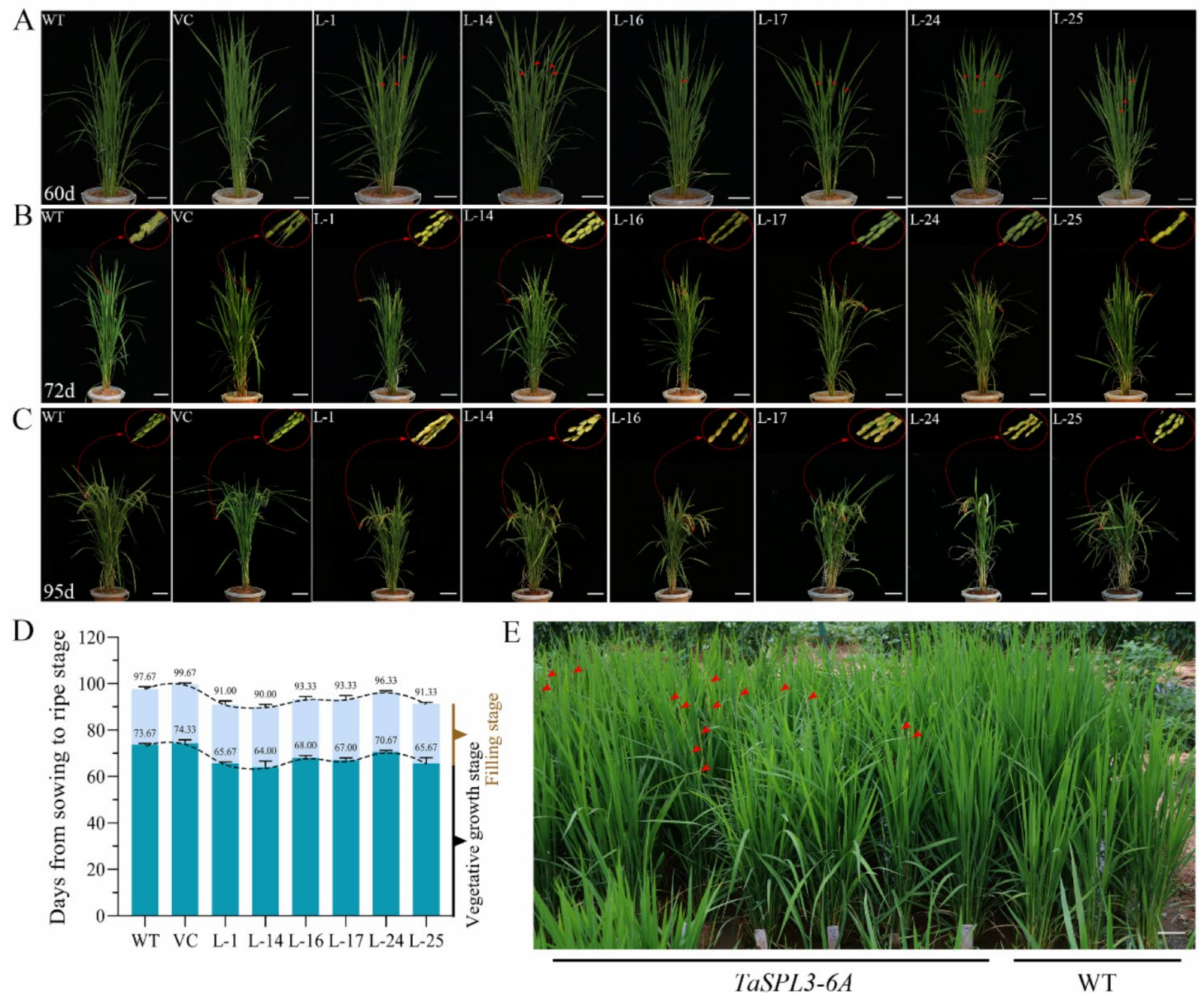
Figure 6. Ectopic expression of TaSPL3 in transgenic rice exhibited early heading phenotype in both greenhouse ( A – D ) and fields ( E ). TaSPL3-OE lines headed earlier than the WT plants in 60 days ( A ), with the TaSPL3-OE panicles becoming mature earlier, as seen at 72 ( B ) and 95 ( C ) days of development. Statistical analysis revealed that the vegetative phase, rather than the reproductive phase, was shorter in the TaSPL3-OE lines than in the WT ( D ). The early heading phenotype was observed for the TaSPL3-OE lines in the T 2 generation in experimental fields. Heading panicles are indicated by red arrows ( E